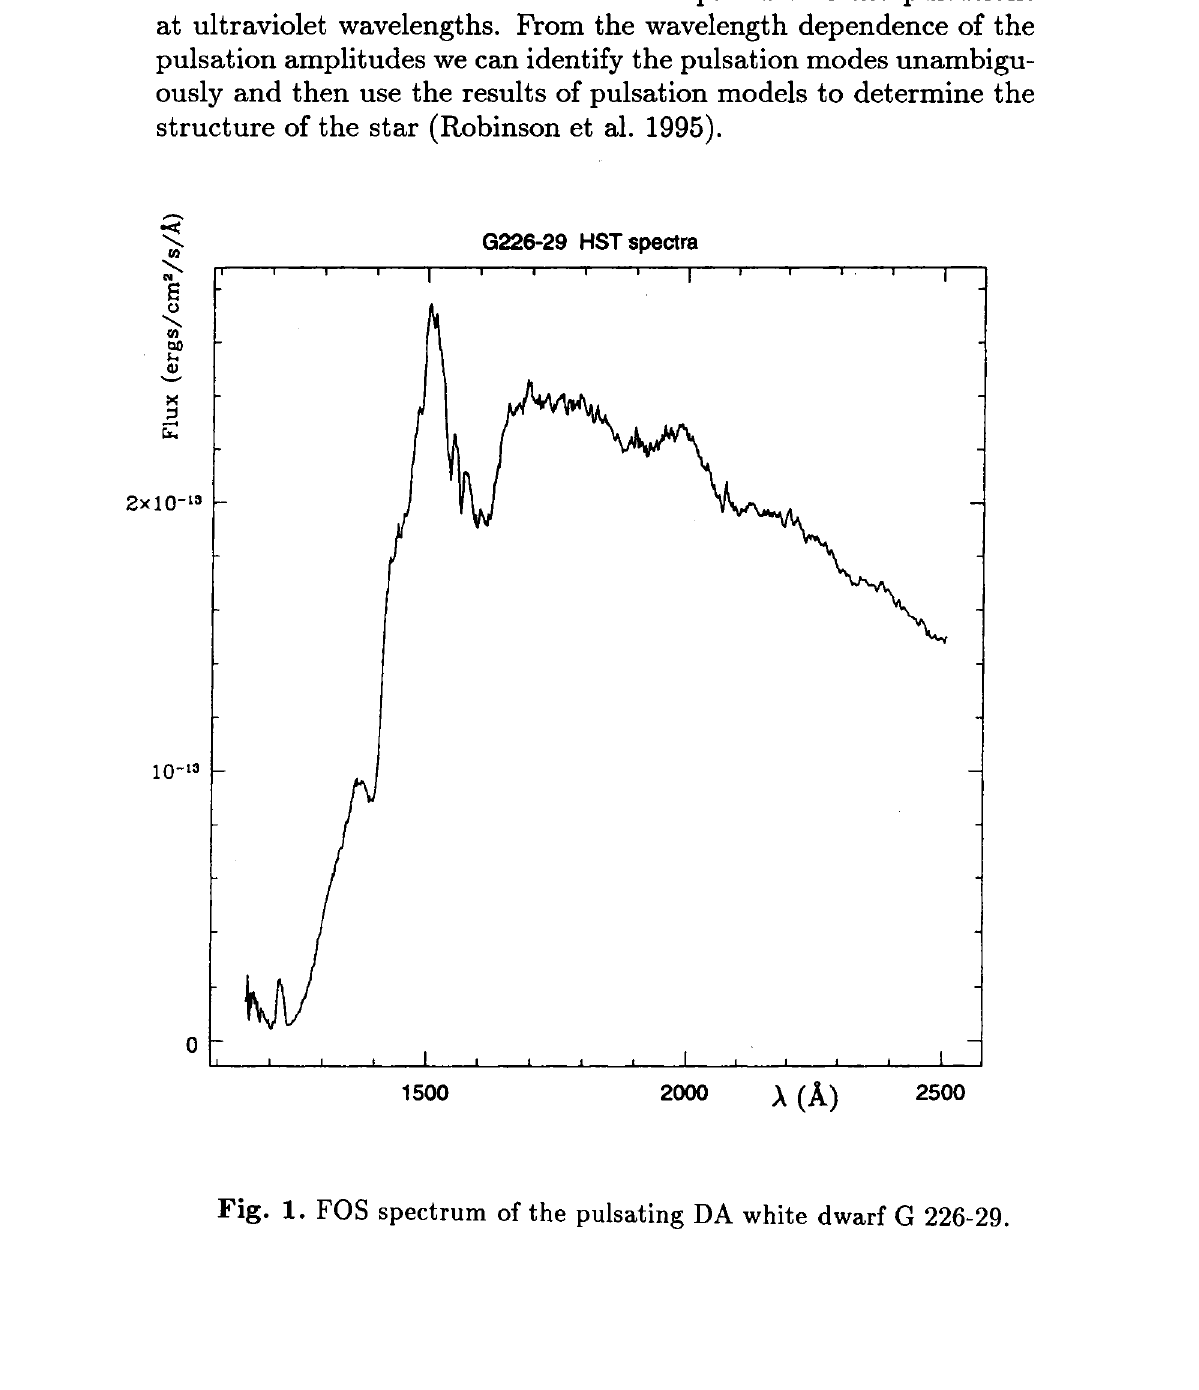
Fig. 1. FOS spectrum of the pulsating DA white dwarf G